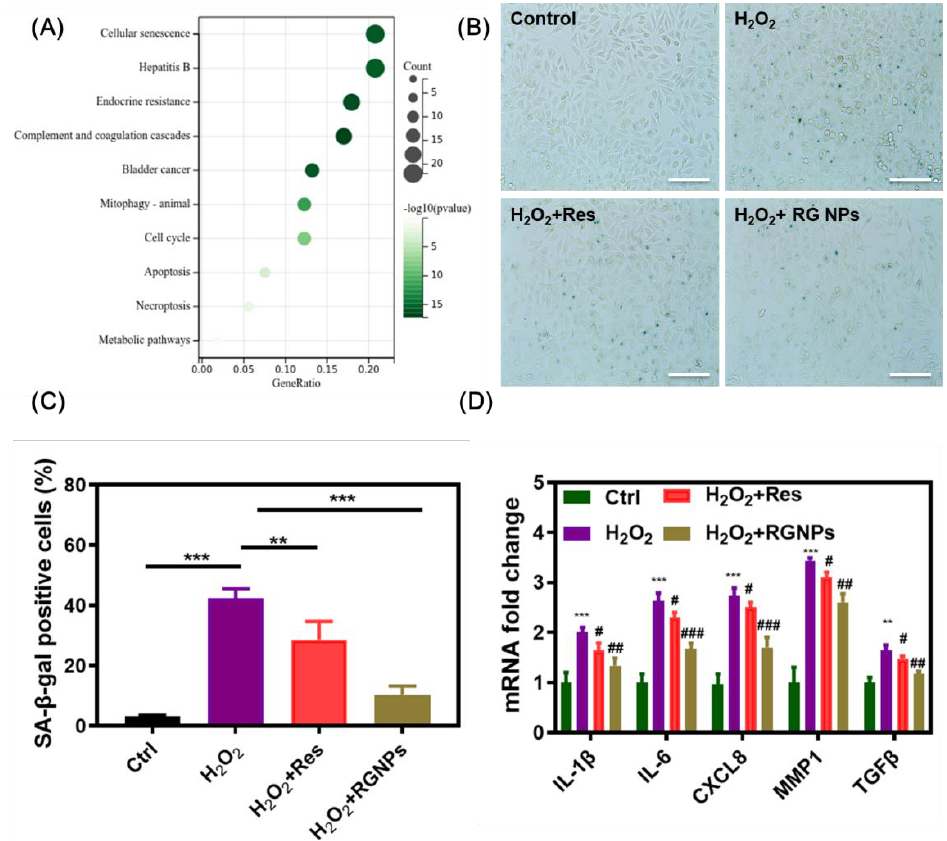
Figure 4. Anti–aging effect of RGNPs. ( A ) Gene Expression Omnibus (GEO) analysis of Res in- volved function enrichment (GSE184636). ( B ) Representative images of senescence-associated- β - galactosidase (SA– β –gal) staining in HLECB3 cells after treatment with Ctrl, H 2 O 2 , H 2 O 2 + Res, H 2 O 2 + RGNPs; the bar was 50 µ m. ( C ) Quantitation of the SA– β –gal–positive cells. ( D ) mRNA fold change of senescence-associated secretory phenotype (SASP) factors (IL–1 β , IL–6, CXCL8, MMP1 and TGF β ) in HLECB3 cells treated with Ctrl, H 2 O 2 , H 2 O 2 + Res, H 2 O 2 + RGNPs. ** and *** indicate H 2 O 2 vs. Ctrl; #, ## and ### indicate H 2 O 2 + Res or H 2 O 2 + RGNPs vs. H 2 O 2 . 2.5. RGNPs Inhibited Cellular Senescence via Activation of the Sirt1/Nrf2 Pathway In Vitro